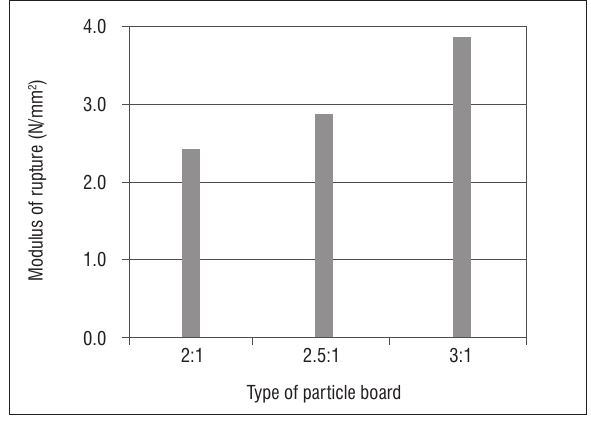
Modulus of rupture of particle board produced using different adhesive–cassava stalk ratios (2:1, 2.5:1 and 3:1).